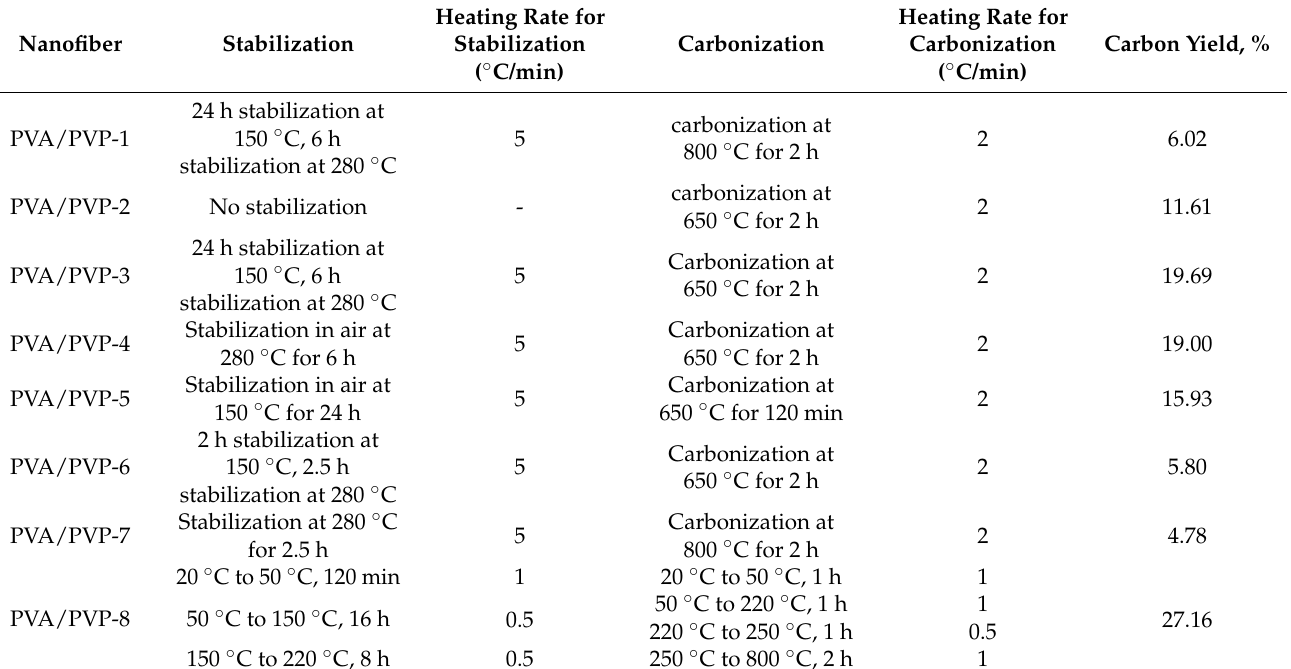
Table 2. Carbonization conditions for PVA/PVP